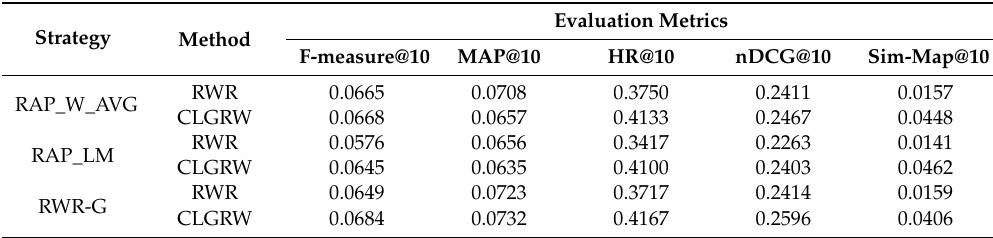
Table 3. Performance of RWR and CLGRW approaches and di ff erent group recommendation strategies including RAP_W_AVG and RAP_LM, and RWR-G on U-U (social relationship) graph (group size: two